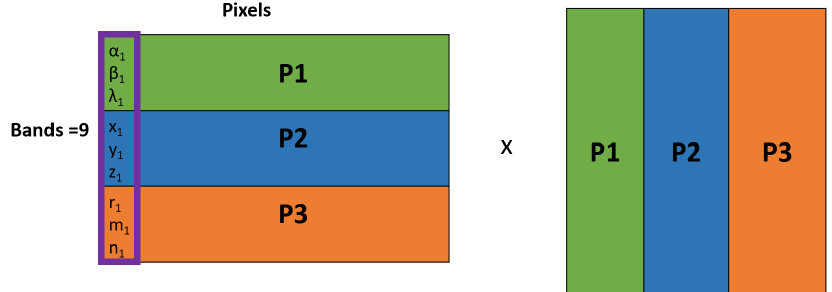
Figure 3. Example of partitioning of input data into blocks. The total number of bands is B = 9 and the block size is B max =